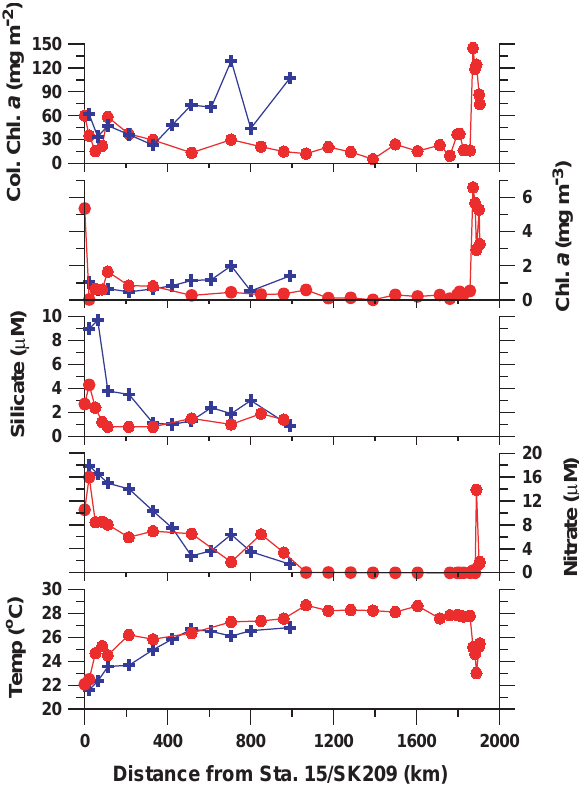
Fig. 3. Area-averaged time series of SeaWiFS and MODIS- Aqua chl- a (a) and optimally interpolated sea-surface temperature anomaly (b) for the period 1997–2009 (since 2002 for MODIS- Aqua chl- a ). Red lines are for the region bounded by Lats. 0 ◦ and 10 ◦ N, and Longs. 52 ◦ and 64 ◦ E; black lines are for the region bounded by Lats. 10 ◦ and 20 ◦ N, and Longs. 52 ◦ and 64 ◦